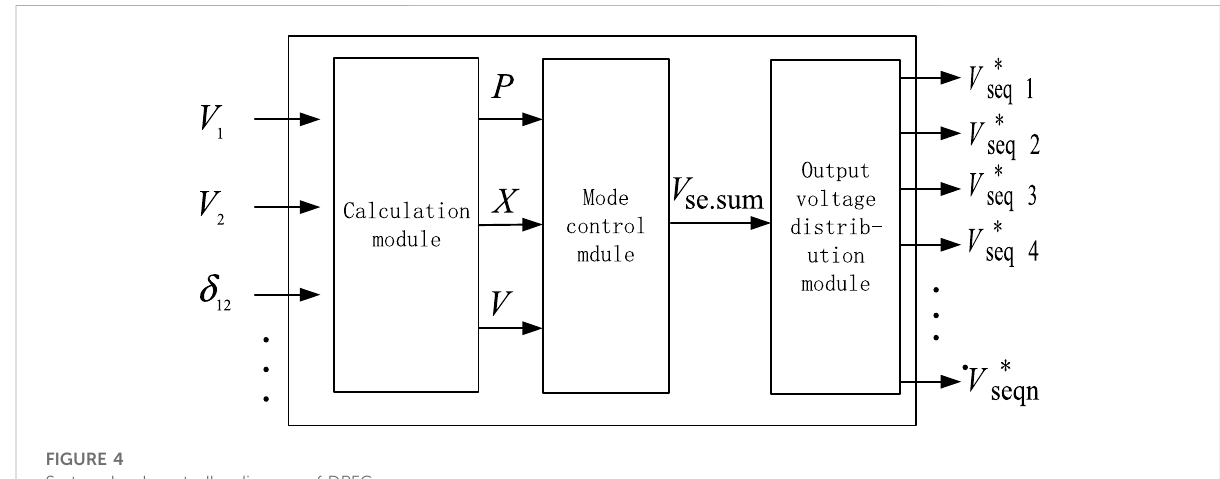
FIGURE 4 System-level controller diagram of